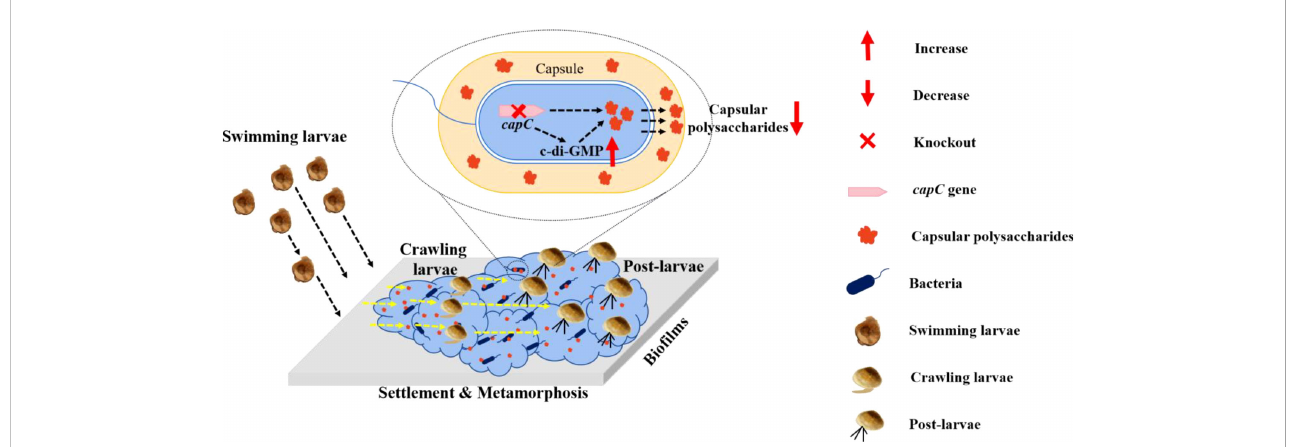
FIGURE 7 Model of capC regulation on larval settlement and metamorphosis: the capsular polysaccharide synthesis gene could modulate bacterial c-di-GMP which regulates the secretion of capsular polysaccharide, and then impact mussel larval settlement and metamorphosis. Once capC is de fi cient, bacterial bio fi lm biomass including cell density and thickness shows no change and capsular polysaccharide secretion is reduced accompanied with upregulation of